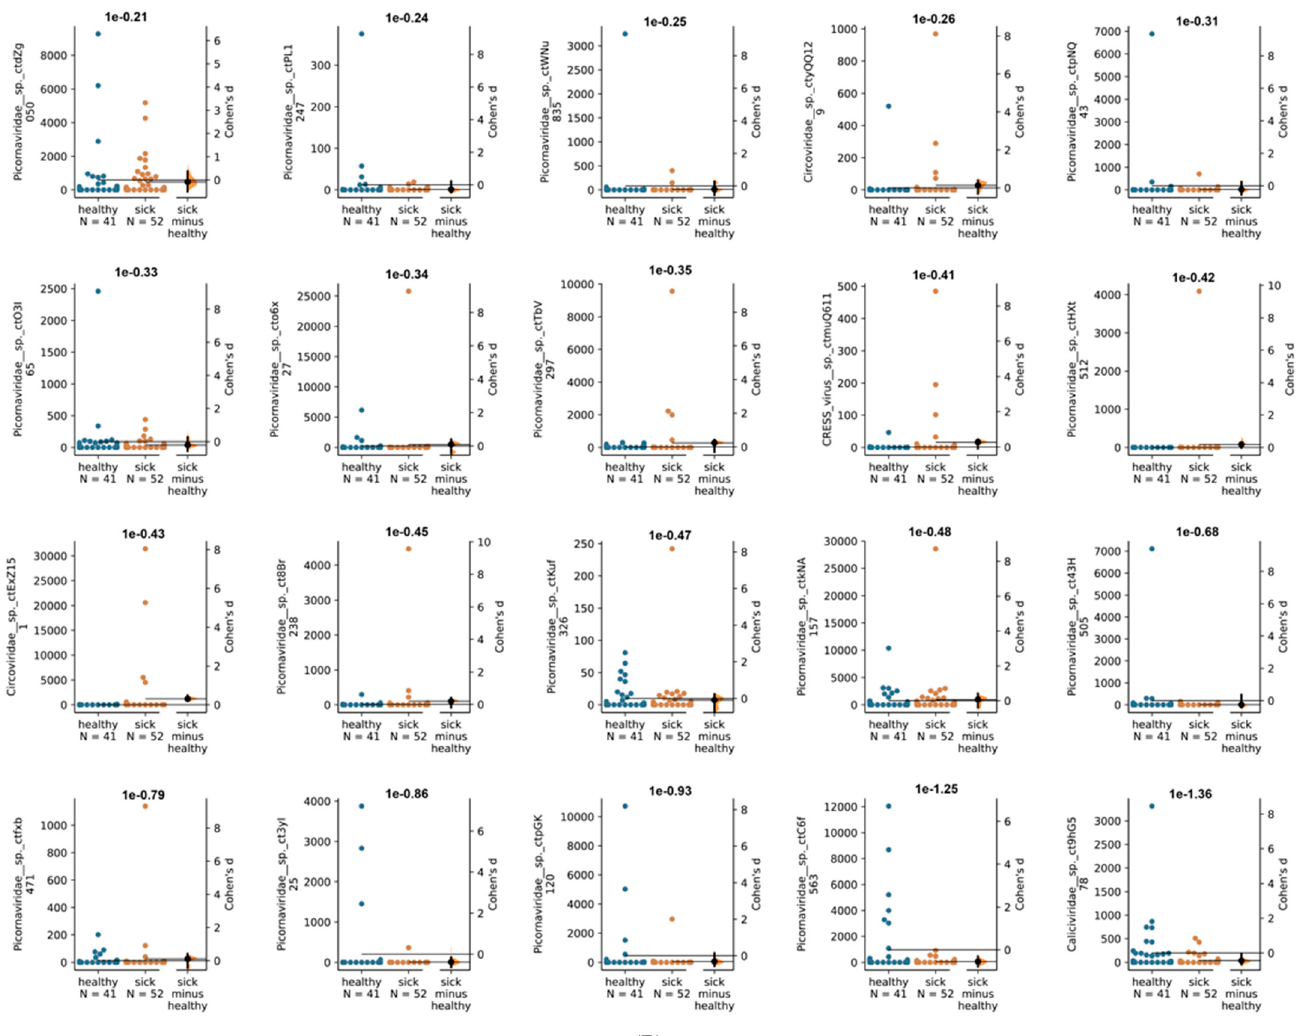
Figure 5. Sample-by-sample comparison of viruses with largest differences between healthy and ICD cohorts. Each plot represents a different virus contig, with RKPM values from healthy and ICD (orange) samples displayed. Cohen’s d effect size values are plotted on the right side of each plot, and uncorrected p values are reported above each plot. Asterisks next to − log10p value on top of each graph were given to virus contigs with significant p values after multiple testing correction. ( A ) 20 virus contigs with the lowest p value overall. ( B ) Eukaryotic virus contigs with lowest p value. Note that most picornaviruses contigs retrieved from de novo assembly represented sub-genomic fragments with >90% average nucleotide identity to previously discovered macaque viruses.